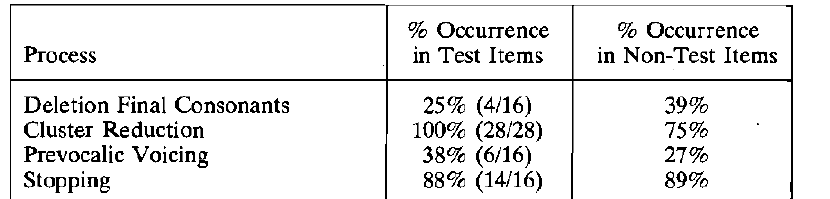
TABLE I: Results of Phonological Process Analysis (Weiner 9 )